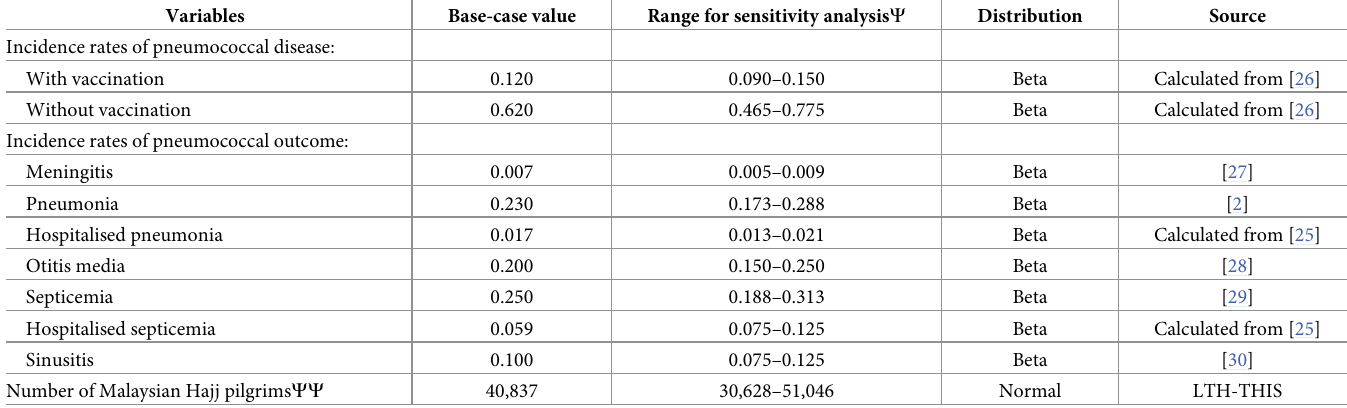
Table 1. Probabilities and estimates associated with pneumococcal